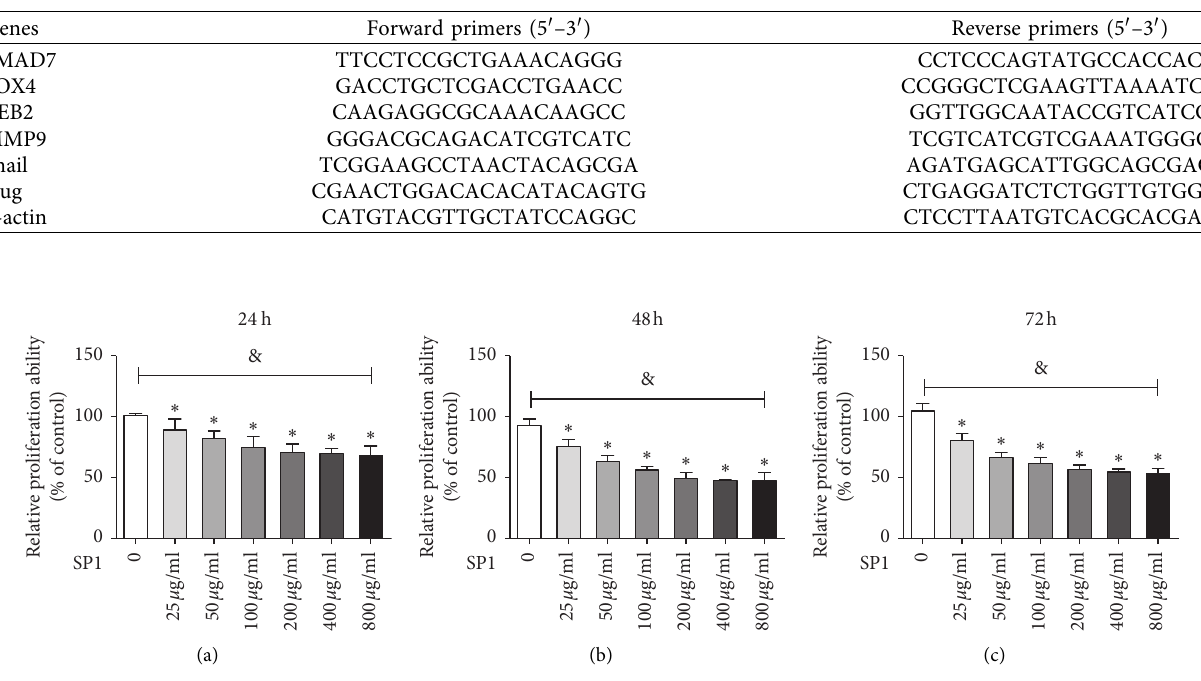
Figure 2: Results of relative cell viability of MGC-803 cells treated with different concentrations of SP1 (0, 25, 50, 100, 200, 400, and 800 μ g/ ml) for 24, 48, and 72 hours, respectively. Compared with 0 μ g/ml SP1-treated (control) group, ∗ P < 0 . 05; & P < 0 . 05 for comparison between groups under different concentrations of SP1